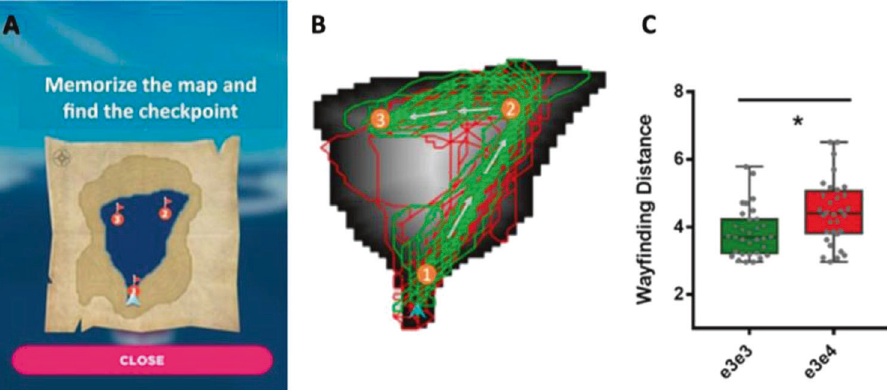
Fig. 2 The way- fi nding game Sea Hero Quest is an example of a gami fi ed smartphone tool that is sensitive to an increased genetic risk of AD ( fi gure reprinted with permission from ref. [117]). A Screenshot from the game. B The spatial trajectories of APOE- ε 4 positive (red) vs. APOE- ε 4 negative (green) participants on a selected Sea Hero Quest level. C The way- fi nding distance on the game differed signi fi cantly based on APOE- ε 4